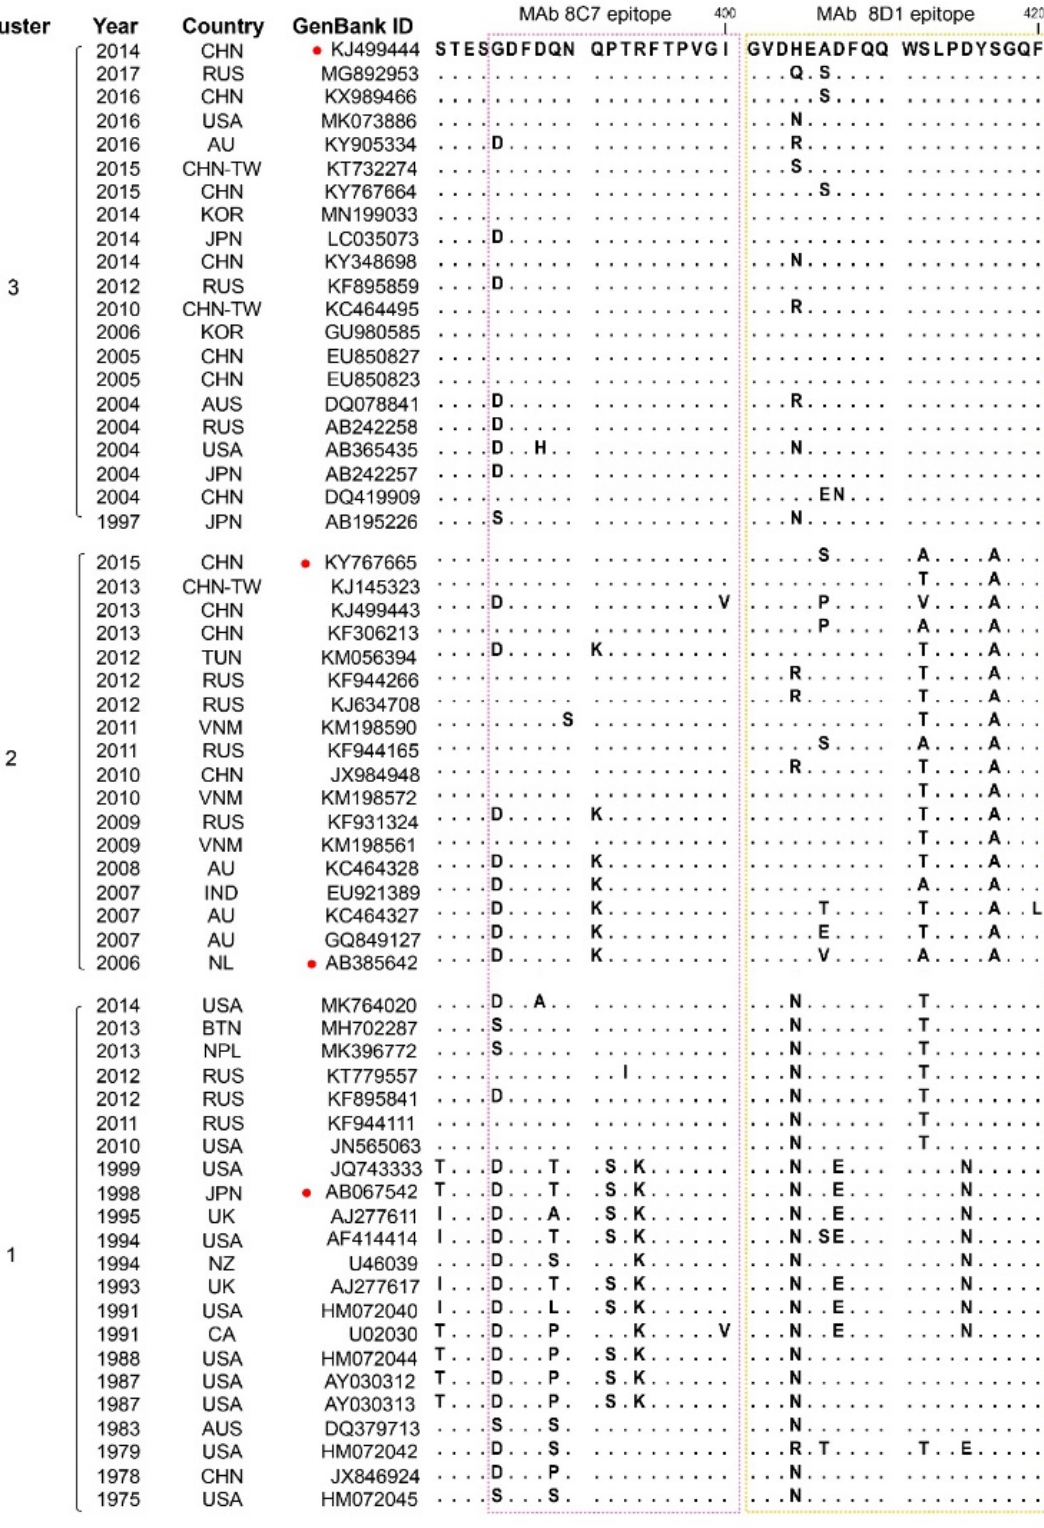
Figure 5. Alignment of the corresponding 8C7 and 8D1 epitope sequences from representative strains of different GII.3 clusters. Information for each strain, including isolation date (year), isolation location (country), and GenBank ID, were shown. The 8C7 and 8D1 epitope regions were boxed with dash lines. Dots represent residues identical to those of the GII.3-KJ strain. Red circle indicates the strains used in this study.